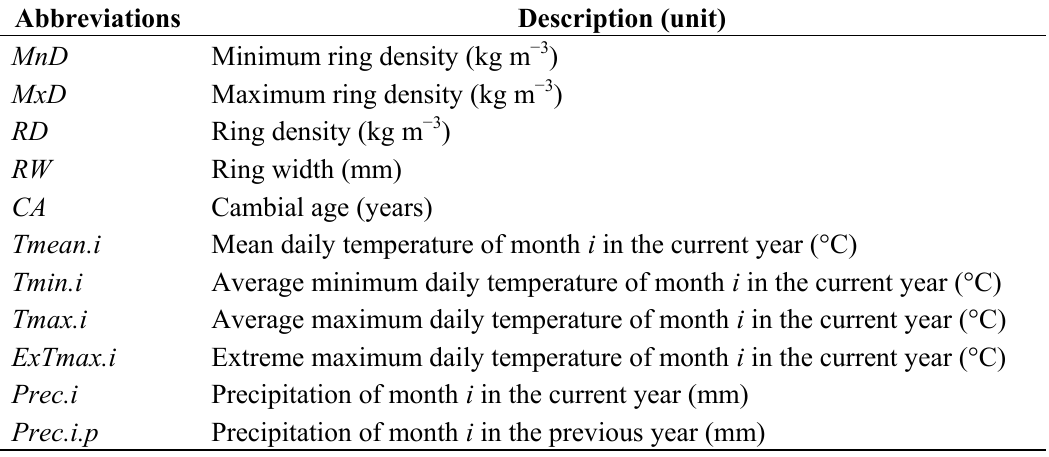
Table 1. Abbreviations used in this article.